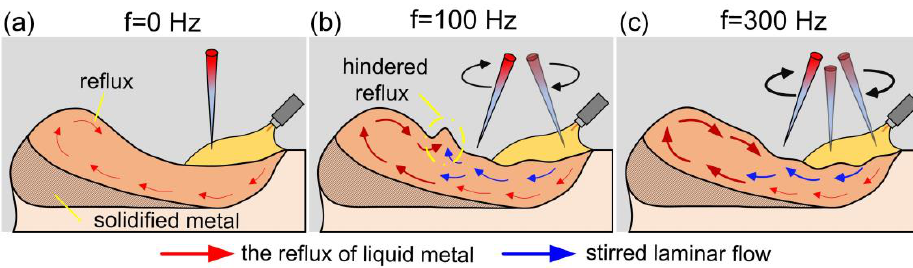
Figure 13. Schematic diagram of hump formation during